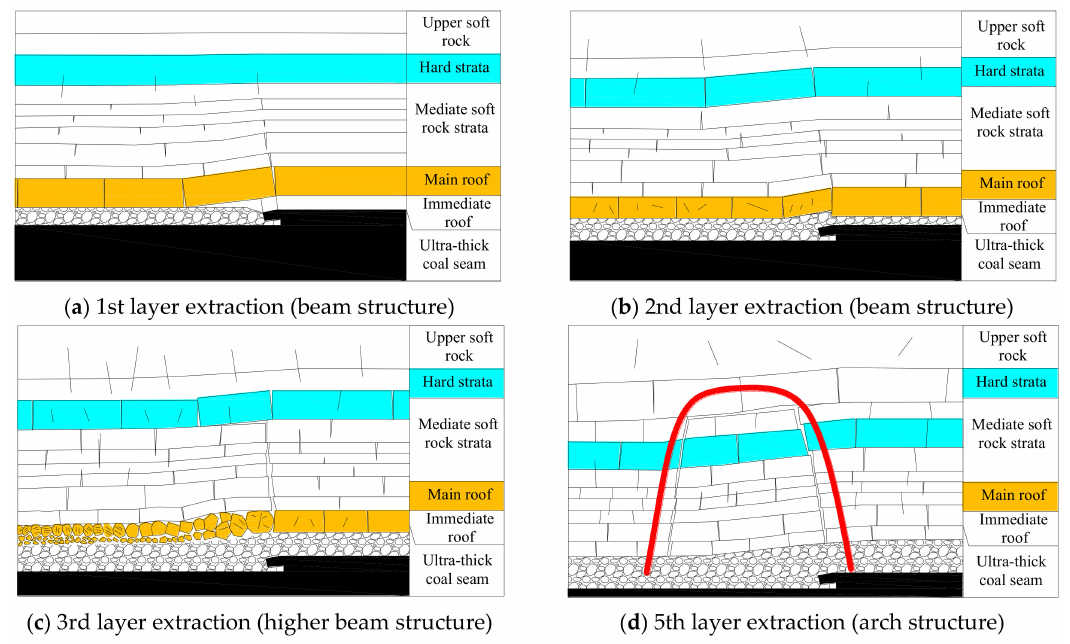
Figure 7. Change of structures in the overburden at different mining stages.